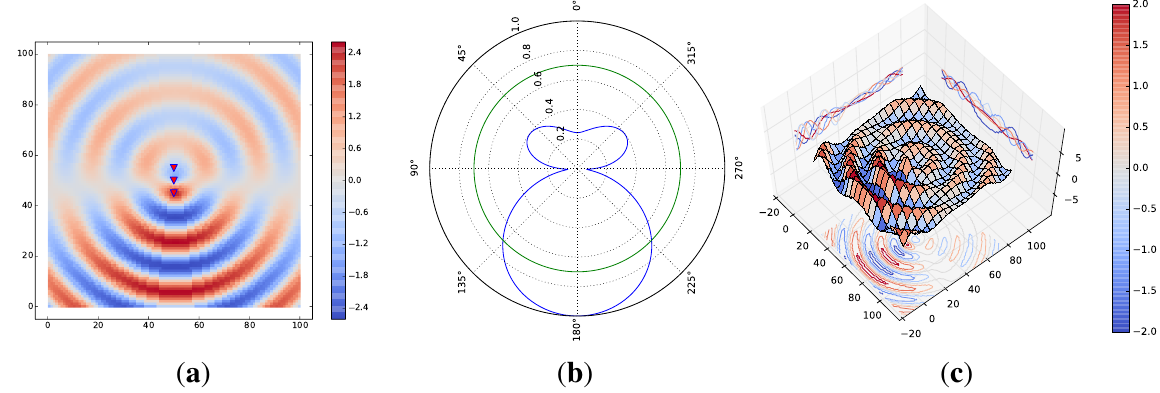
Figure 3. Three LDWuRs cooperate to form the beamforming. ( a ) 2D beam pattern; ( b ) beam pattern size; ( c ) 3D beam